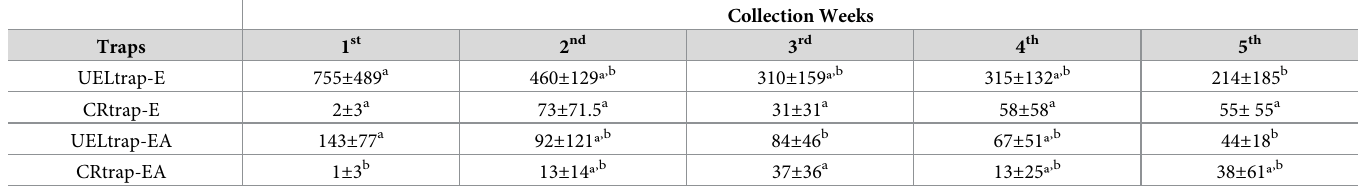
Table 5. The average and standard deviation of the Aedes obtained from each trap from January to February 2018 in Manaus, Amazonas, Brazil.